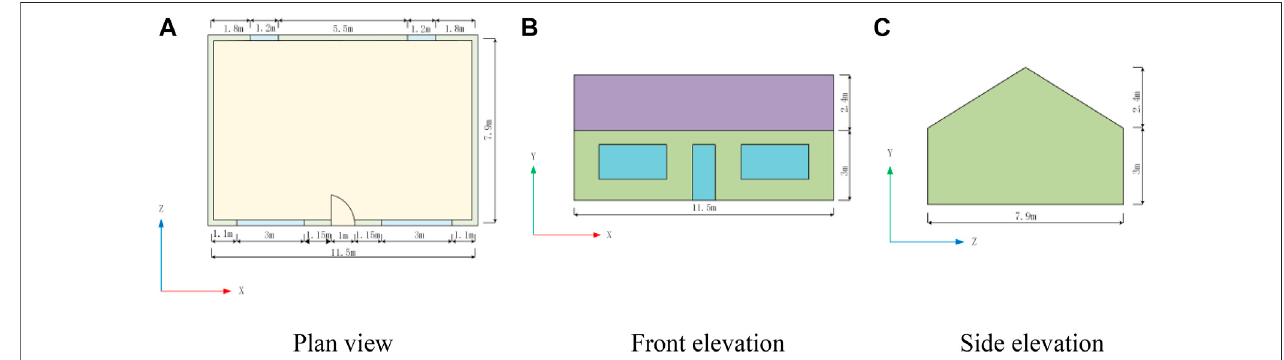
FIGURE 1 | Detail dimensions and layout of the single-story masonry structures. (A) Plan view. (B) Front elevation. (C) Side elevation.